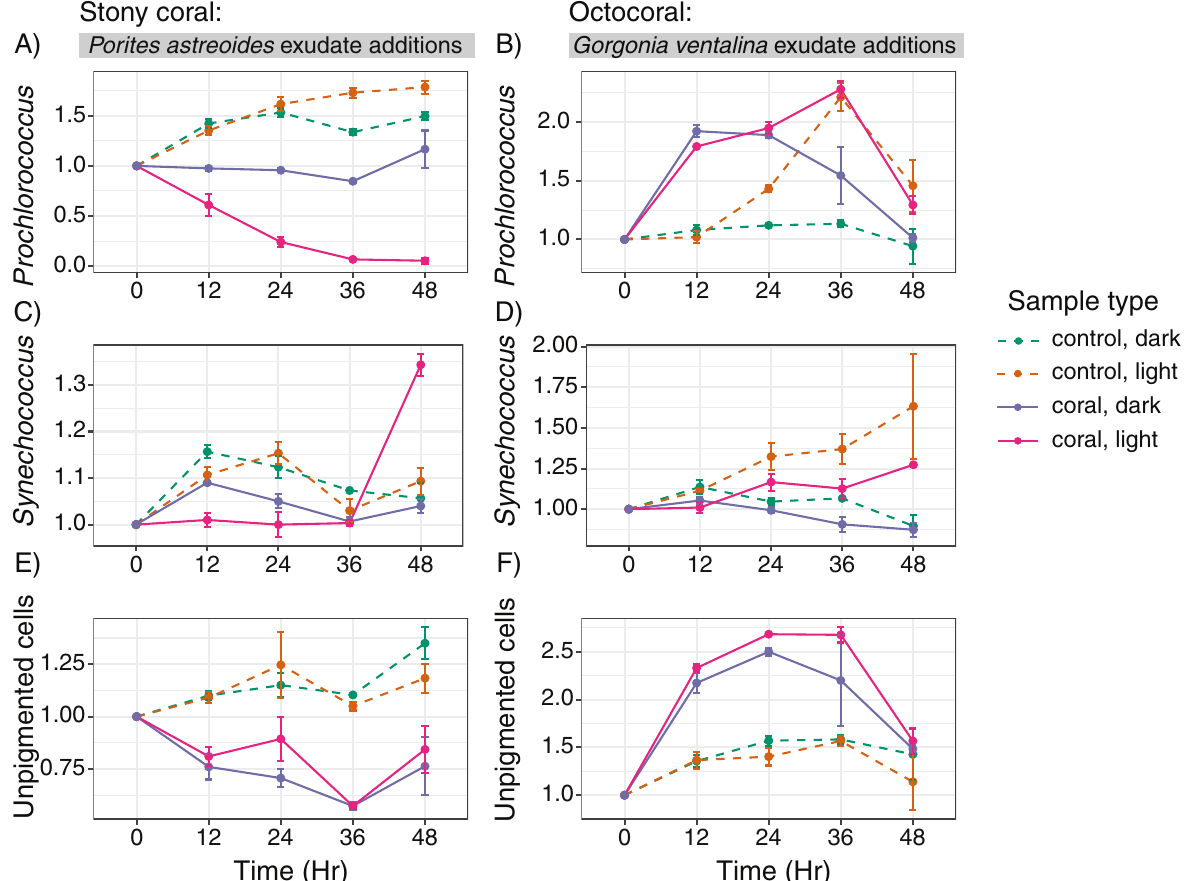
Fig. 3 Abundances of Prochlorococcus , Synechococcus , and unpigmented cells respond differently to exudates from Porites astreoides and Gorgonia ventalina . Line graphs of normalized cell counts of Prochlorococcus ( A , B ), Synechococcus ( C , D ), and unpigmented cells ( E , F ) show differing responses of microbial communities to Porites astreoides ( A , C , E ) and Gorgonia ventalina ( B , D , F ) exudates. Color corresponds to sample type, symbols represent average cell counts across replicates, and error bars re fl ect standard error across replicates ( n = 3 per treatment type). Dashed lines represent controls and solid lines represent coral exudate addition